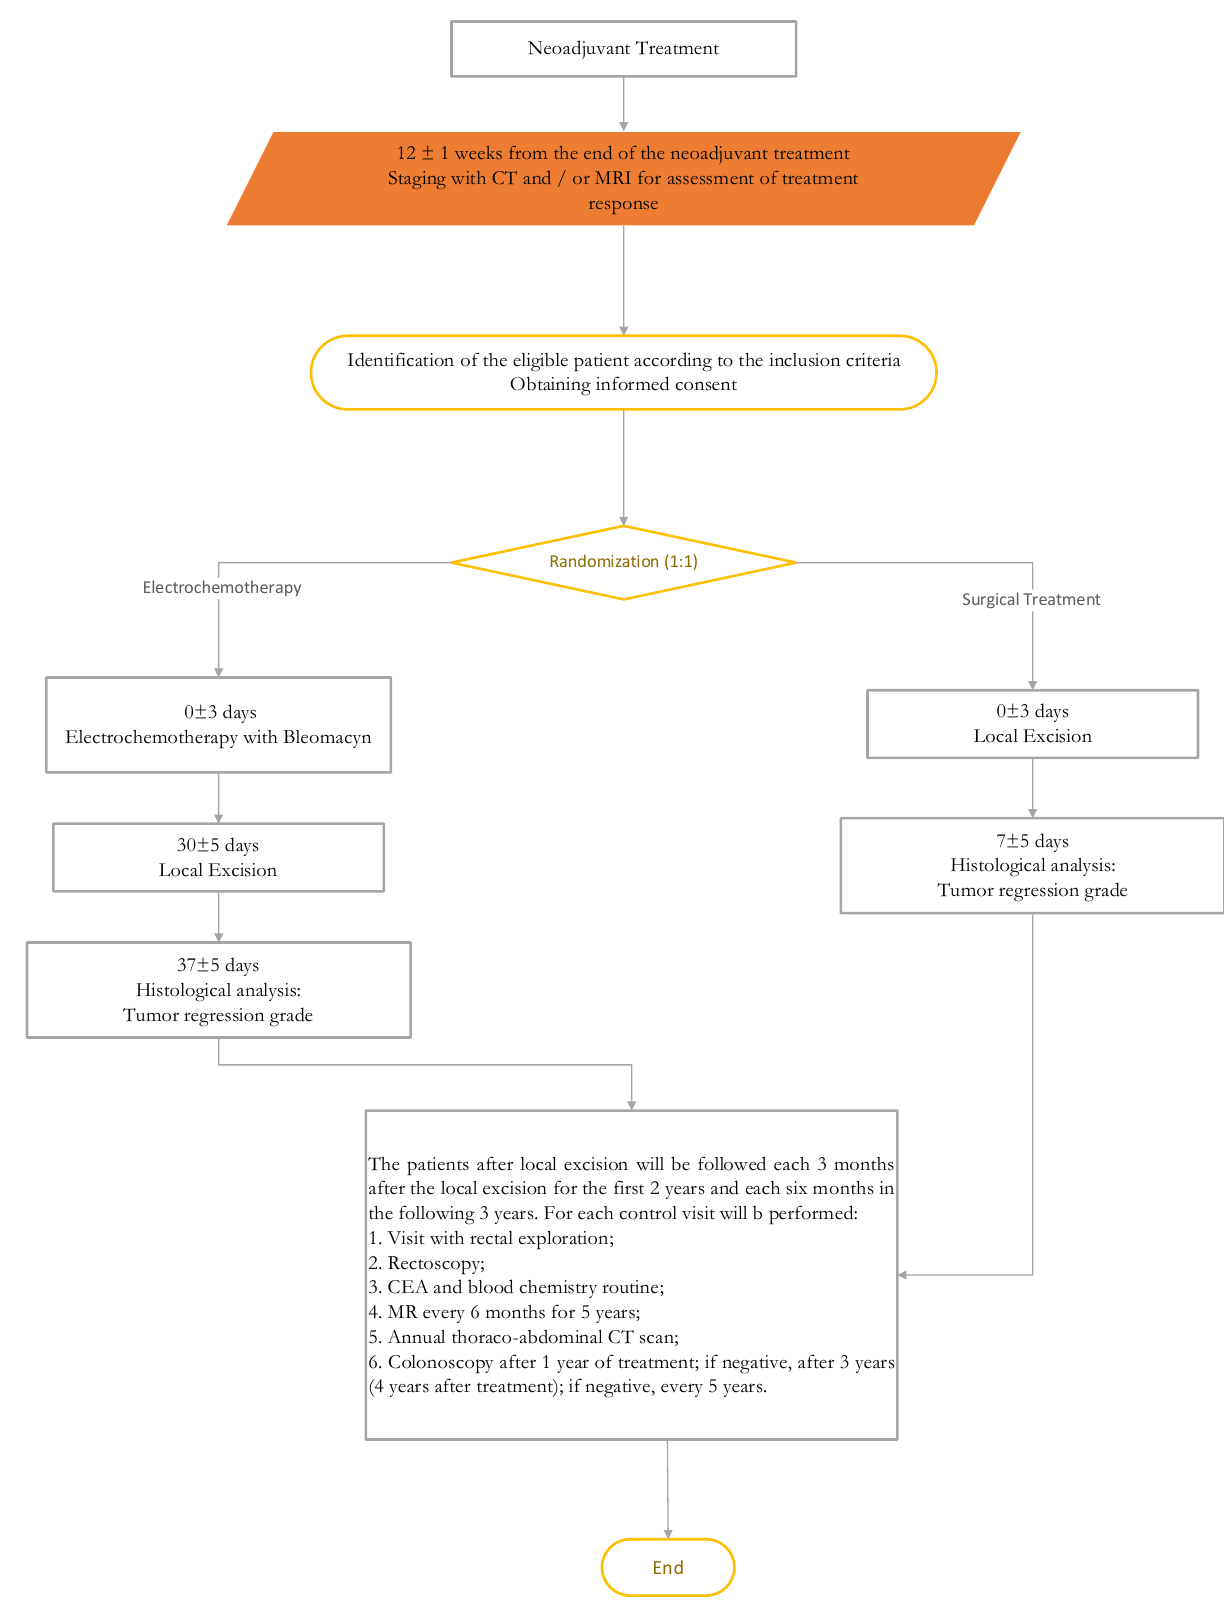
Figure 1. Trial design flowchart.